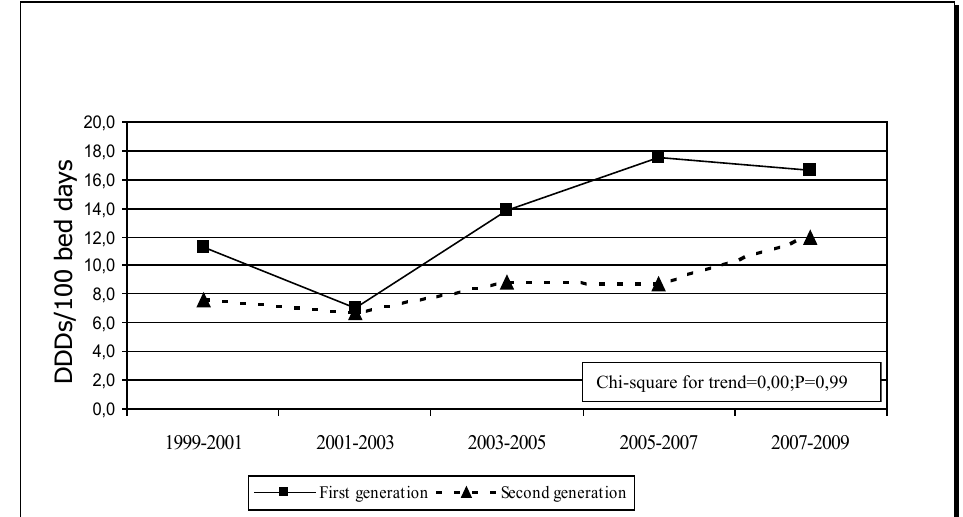
Figure 2. Utilization of first and second generation antihistamines as number of DDDs/100 bed days.